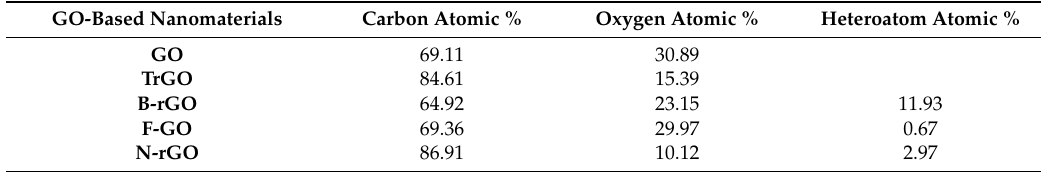
Graphene Oxide (GO), Thermally Reduced Graphene Oxide (TrGO), Boron-doped partially Reduced Graphene Oxide (B-rGO), Fluorine-doped partially Reduced Graphene Oxide (F-rGO), Nitrogen-doped partially Reduced Graphene Oxide